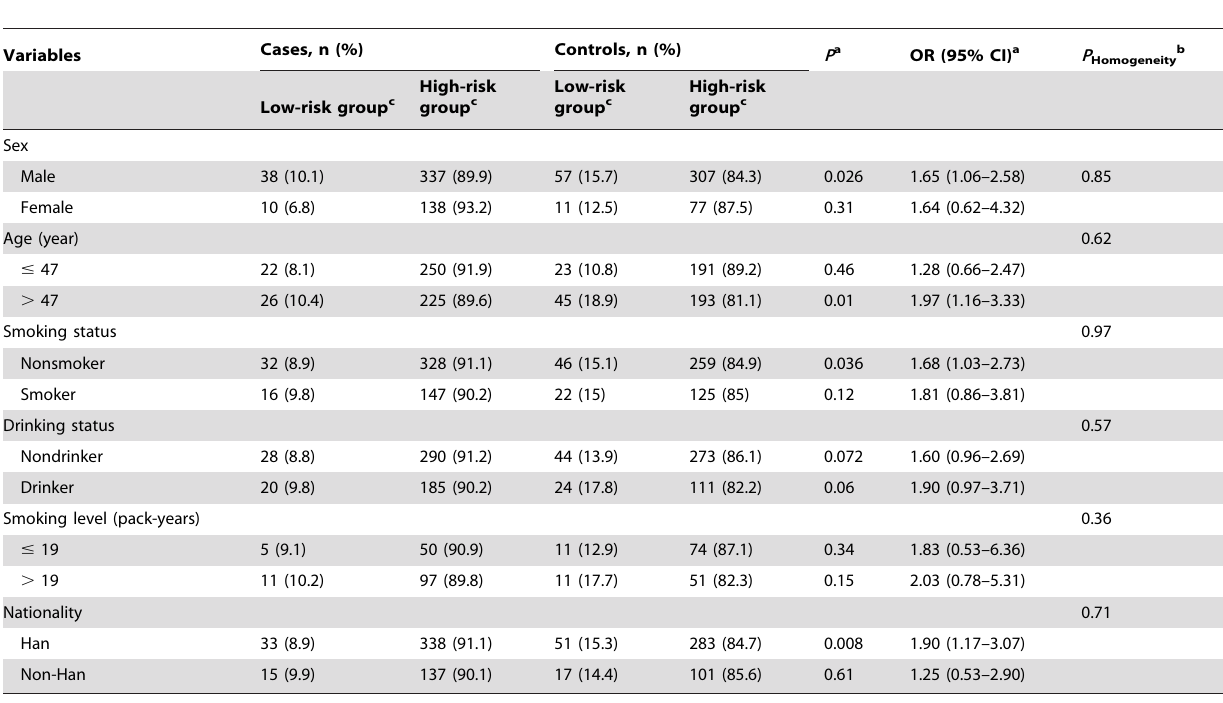
Table 4. Stratification analysis of the combined genotypes of the PTEN , AKT1 , MDM2 and p53 polymorphisms and risk of nasopharyngeal